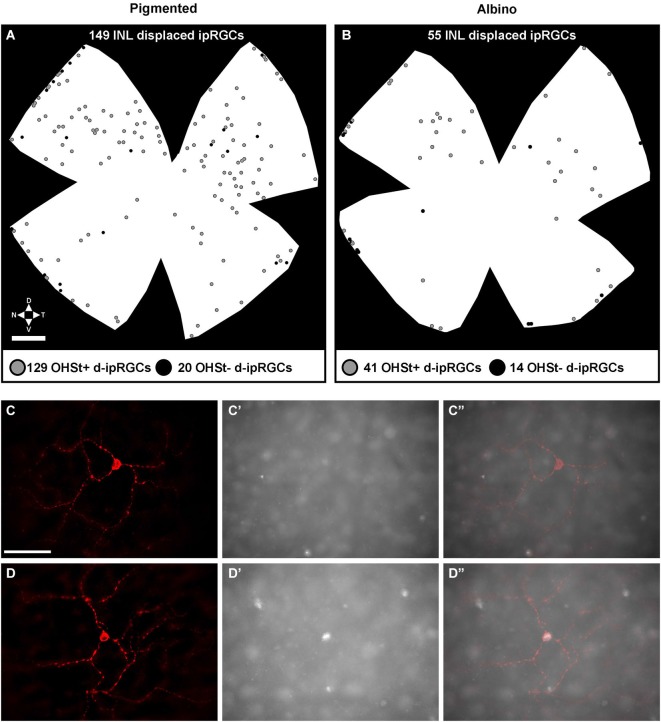
Distribution of displaced ipRGCs (d-ipRGCs) in pigmented and albino retinae. (A,B) Plots depicting the distribution of d-ipRGCs in a pigmented (A) and an albino (B) retina traced from the ON. Each dot represents a single d-ipRGC. Grey dots: d-ipRGCs traced from the ON (OHSt+). Black dots: d-ipRGCs that are not traced from the ON (OHSt−). (C–D”): magnifications from a flat mounted retina traced from the ON where OHSt− d-ipRGC (C,C”) and OHSt+ d-ipRGC (D–D”) are observed. (C,D) melanopsin signal, (C’,D’): OHSt signal. (C”,D”): merged images. Scale bar in (A) 500 µm in (C) 100 µm.